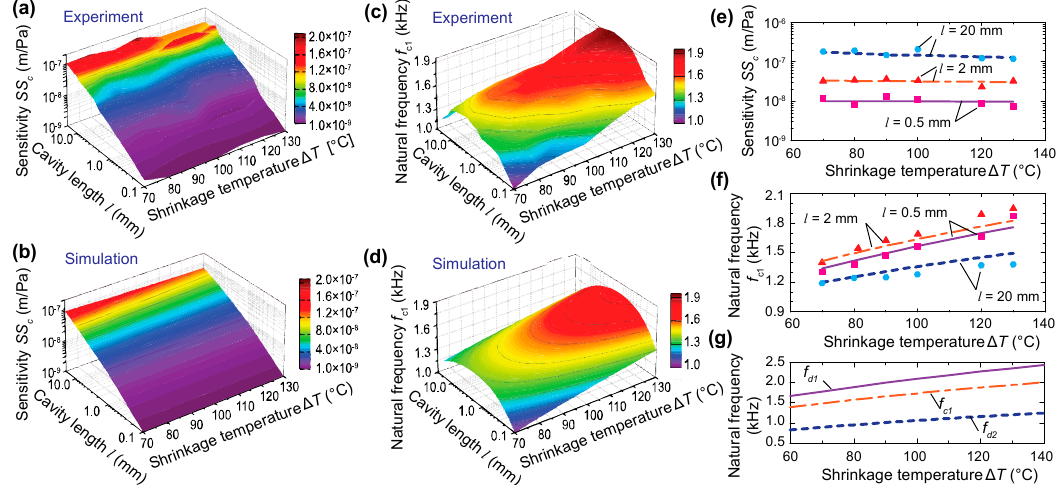
Figure 5. Parametric study by changing the in-plane tension in the diaphragm via thermal expansion and cooling. ( a , b ) Contour plots of sensitivity as a function of cavity length l and shrinkage temperature ∆ T (( a ) experiment, ( b ) simulation). ( c , d ): same as ( a , b ) but for the natural frequency. ( e , f ): Mechanical sensitivity ( e ) and natural frequency ( f ) as a function of ∆ T for three di ff erent cavity lengths: 0.5 mm, 2 mm, and 20 mm (scatter points: experiment, lines: simulation). ( g ) Simulated natural frequencies of the first two modes of the diaphragm in vacuo (denoted as f d 1 and f d 2 ) and the first fundamental frequency of the air-backed diaphragm with l = 2 mm, denoted as f c 1 .